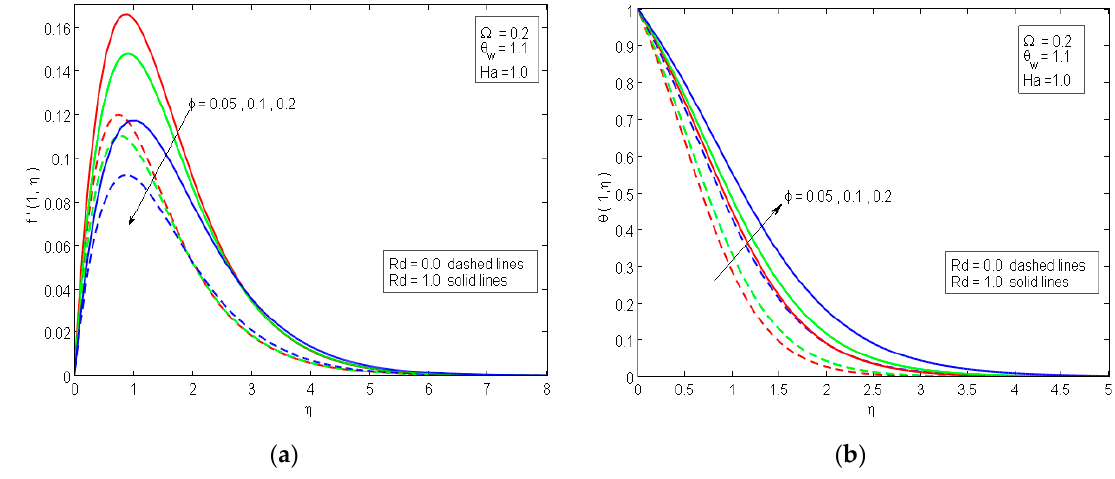
Figure 5. The effectiveness of φ and Rd on velocity field ( a ) and on temperature field ( b ).